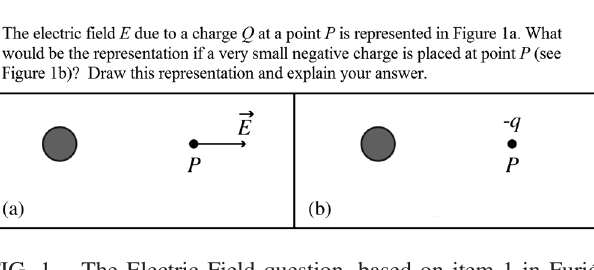
FIG. 1. The Electric Field question, based on item 1 in Furió and